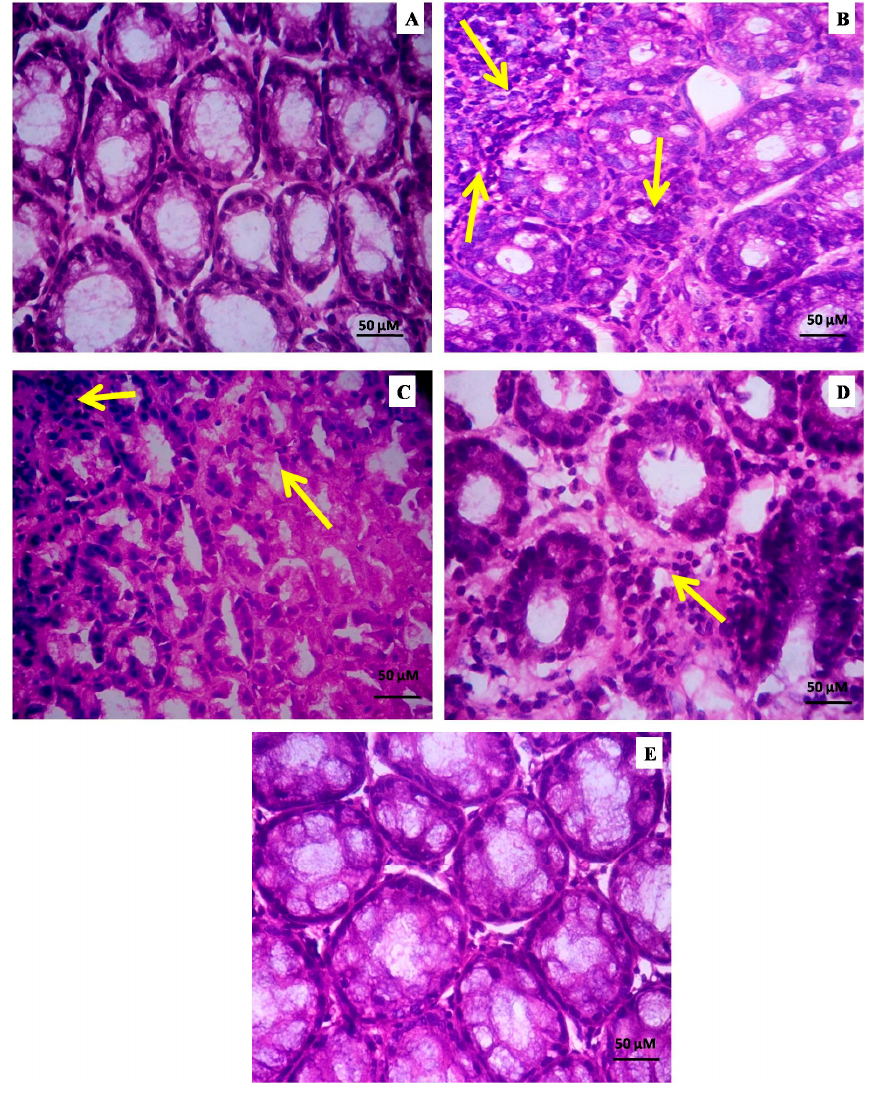
Figure 4. Histopathological changes in colons from mice stained with H&E. ( A ) Control mice receiving saline only, showing normal histological structures. ( B ) 5% AA-induced colon with ulcerative colitis, Group 2 showed marked neutrophil infiltration, thickening of colonic mucosa, severe destruction of epithelial structure with ulceration and infiltration of inflammatory cells compared with control (group 1). ( C , D ) Mice were administered with AA, Sal B (10, 20 µ g/kg respectively), Group 3 and 4 showed mild histological colonic mucosa changes ( C , D ). Group 5 showed the intact colonic mucosa structure, milder congestion and edema and less inflammatory cell infiltration ( E